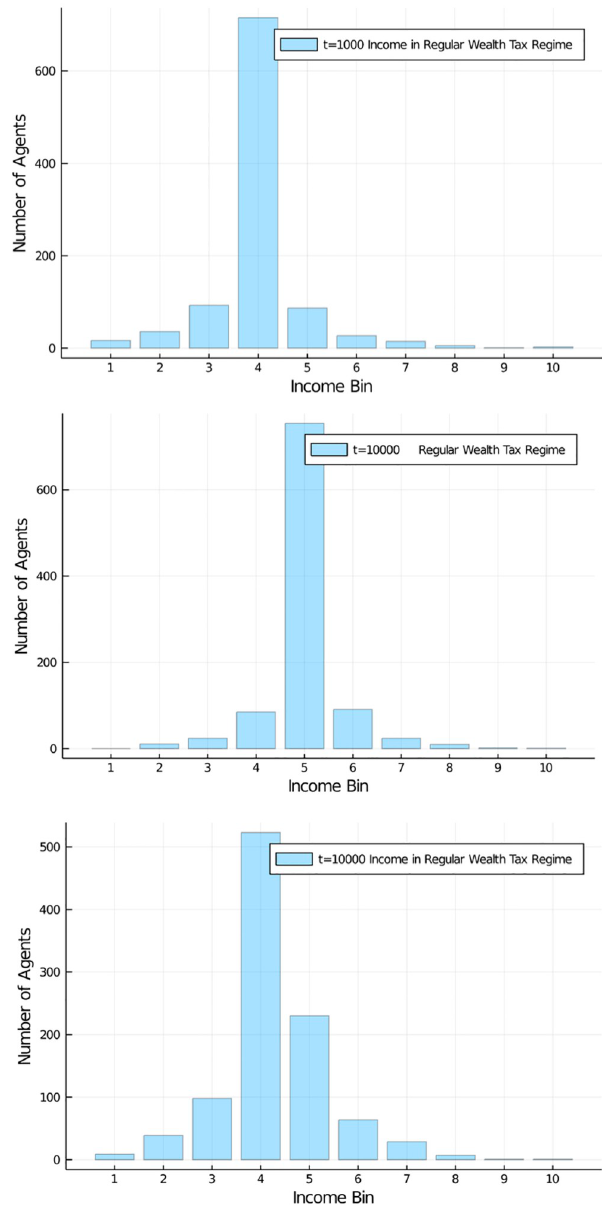
Fig 10. Wealth tax effects. Development of wealth distribution in population of 1,000 agents (10 bins, a.u.). Flat wealth tax regime, with regular flat tax of 30% at t = 1, 000;10, 000; and 100, 000 iterations. Initial distribution was equal among all 1,000 agents. Very effective redistribution of wealth, keeping the middle class